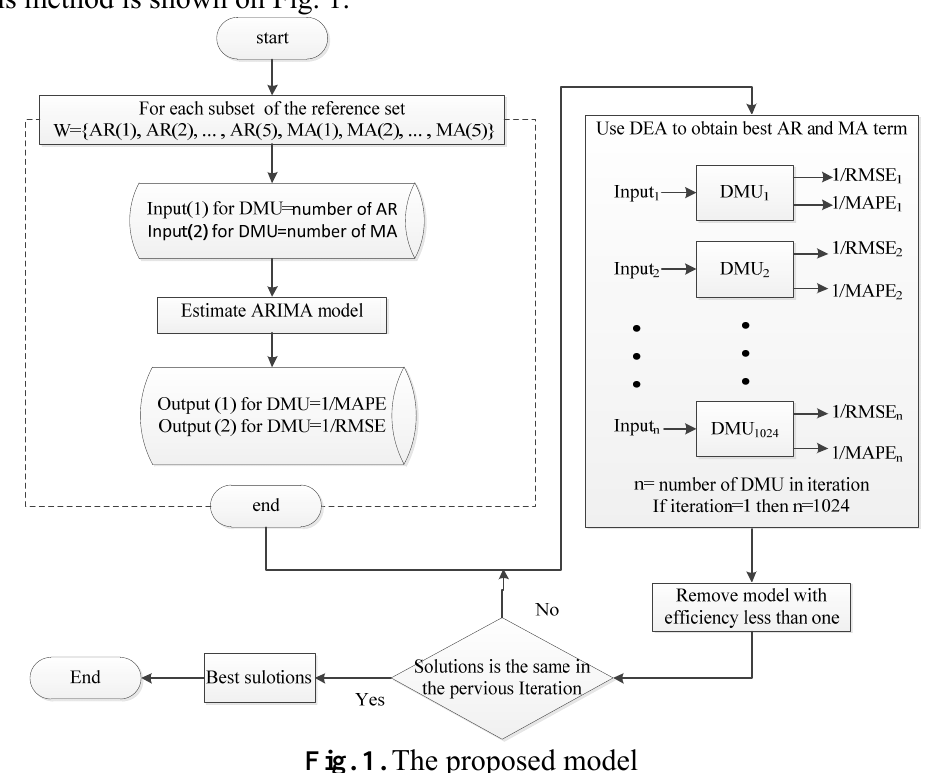
Fig. 1. The proposed model